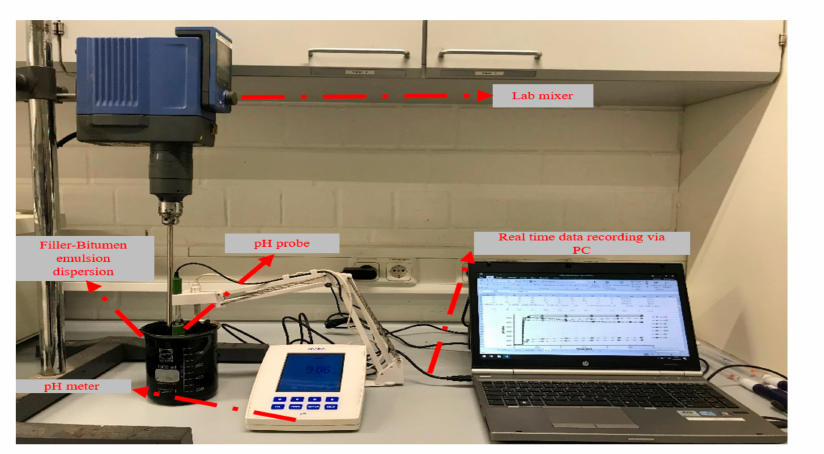
Figure 4. Experimental setup for continuous pH monitoring